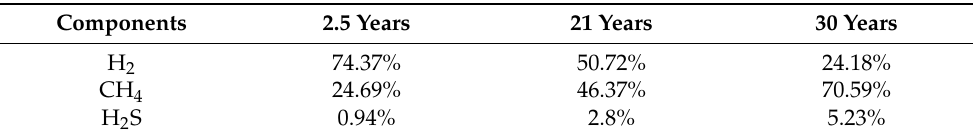
Figure 1. Hydrogen (black), methane (red) and hydrogen sulfide (blue) molar fractions as a function of time (years) [28]. Table 2. Composition of the gas stored in the salt cavern at 2.5, 21 and 30 years as computed by Hemme and van Berk [28].